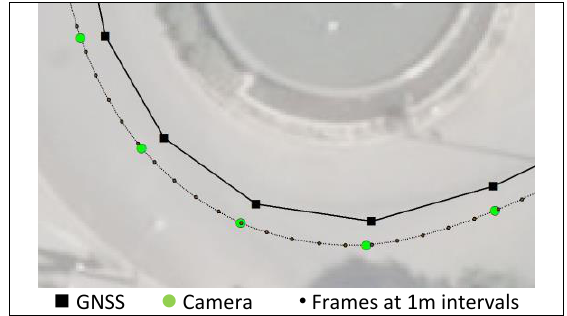
Figure 4. GNSS, camera positions transported from GNSS, and interpolated camera positions at 1 m